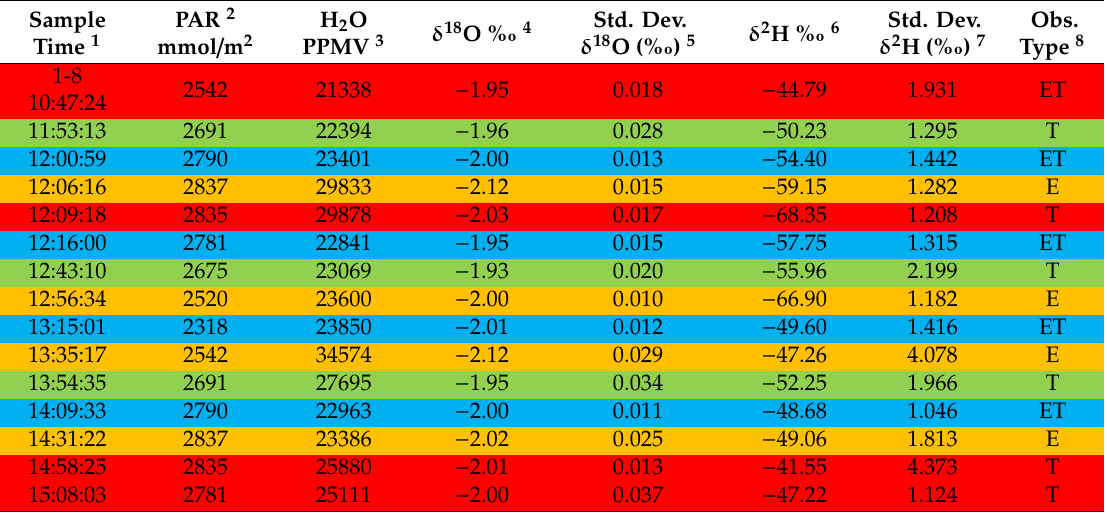
Table 2. Water-vapor isotope composition, concentration, type of observation, and sample time in Big Cypress, Florida, April 2014.